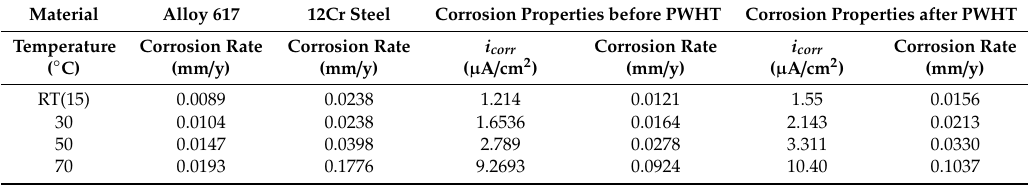
Table 3. E ff ect of PWHT on the corrosion characteristics at various